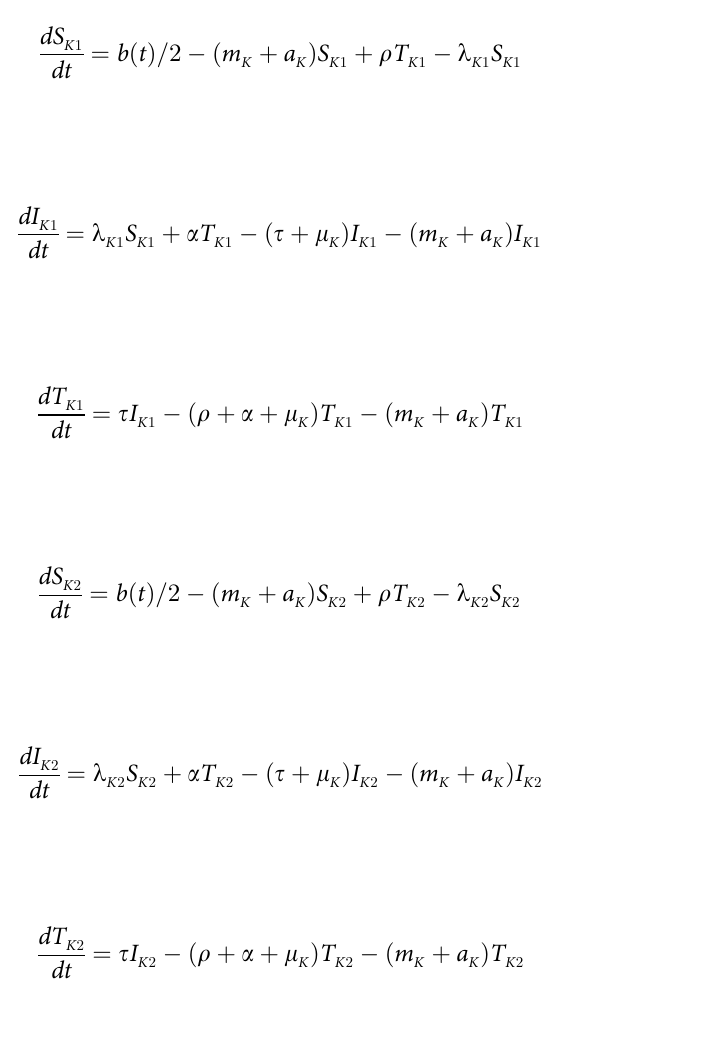
Male and female kittens are born at a rate b ( t ) in the susceptible class, S . Susceptible kittens k can die of natural death or age into the young class. Infection during the first year of age occurs by contact with other animals at a rate β . Infected kittens, I can die of natural infection or F k from sporotrichosis, or be treated and move to the T compartment. Treated animals can die k from natural causes, or abandon the treatment and become infected again. If the animal com- pletes the whole treatment, it may recover from the infection and move back to the susceptible compartment, since the infection does not confer immunity.